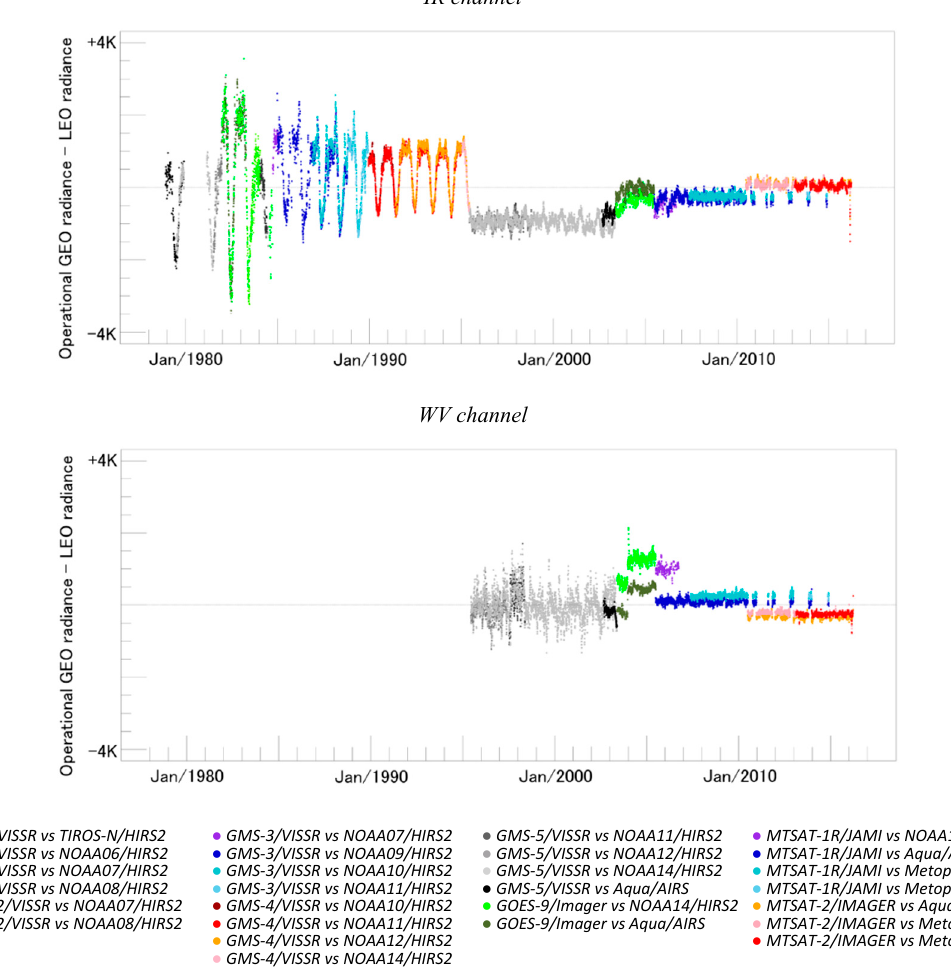
Figure 8. Time series of biases at standard radiance (before prime reference correction) for operational GEO radiances against low earth orbit (LEO) (HIRS, or IASI, or AIRS) radiance. For convenience the biases are presented as brightness temperatures. The conversion between radiance and brightness temperature uses Sensor Planck Function suggested by Tahara